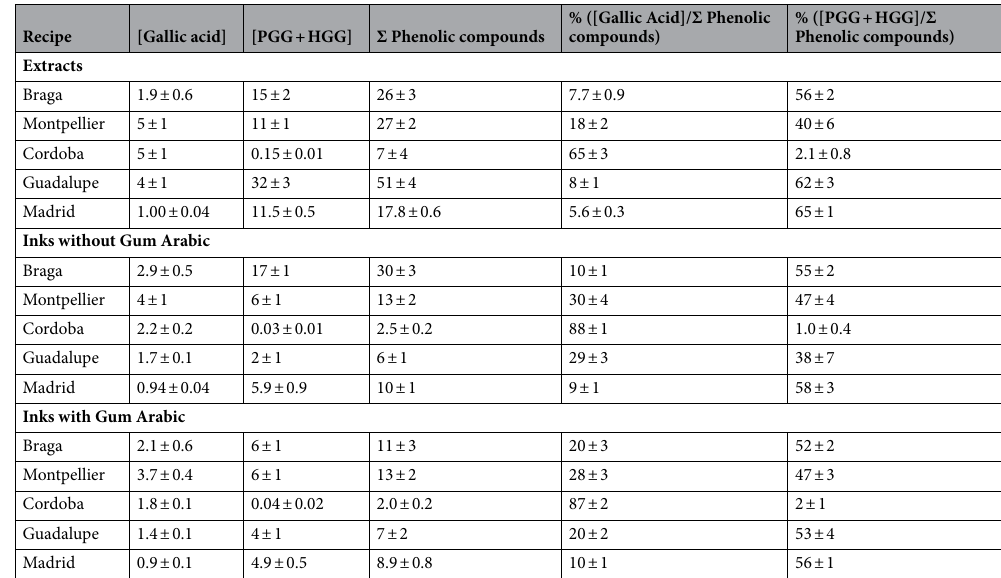
Table 3. Concentration of gallic acid and sum of PGG and hexagalloylglucose (HGG) (expressed in mg/mL of equivalents of gallic acid), sum of all phenolic compounds and ratios: gallic acid/sum of phenolic compounds and PGG + HGG/sum of phenolic compounds found in the extracts and inks following the 5 medieval